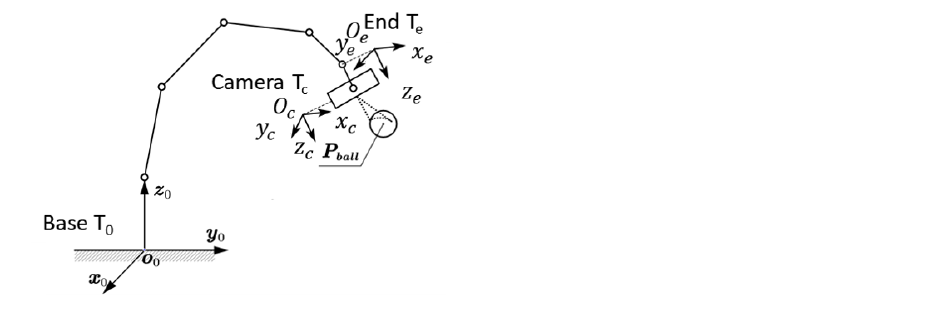
Figure 3. The relative relationship between the center of the laser calibration sphere and the profiler coordinate system.